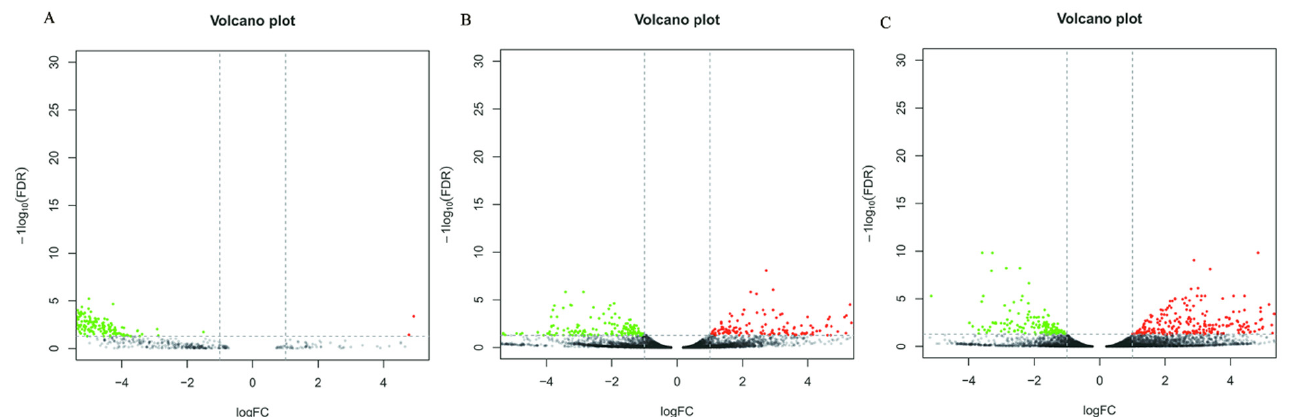
Figure 4. Differential Expressed Gene Volcano plot of CK vs. T1 ( A ), T1 vs. T2 ( B ) and CK vs. T2 ( C ) comparison groups. Note: Red represents genes that are upregulated, green represents genes that are downregulated, and black represents no difference. FDR < 0.05 and a difference multiple greater than 2 were used as the criteria for judging the difference in expression levels.